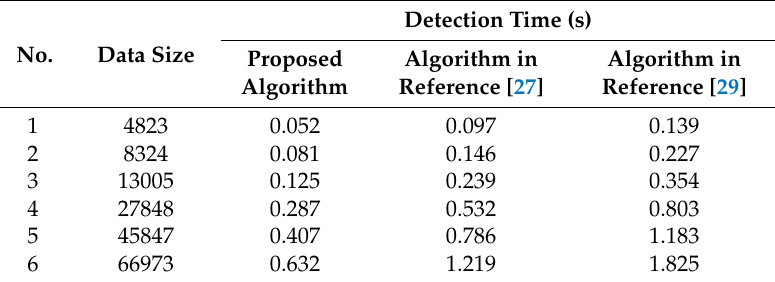
Table 6. The detection efficiencies of different